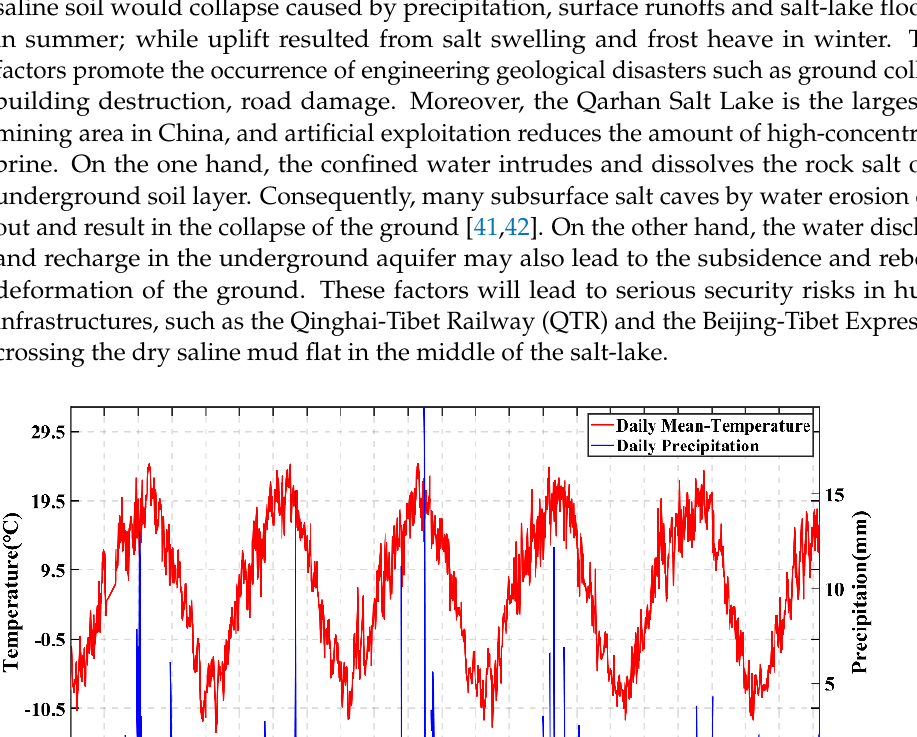
Figure 4. The daily temperature and precipitation data of the Golmud station (36.417° N, 94.9°